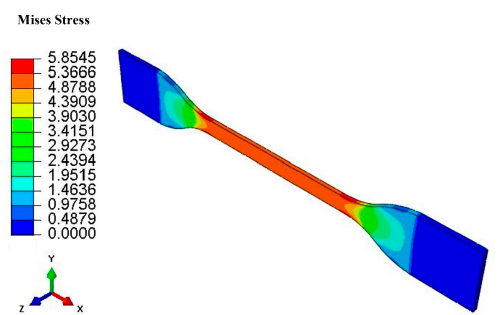
Figure 11. Contour plot of the Mises stress obtained at the peak strain of 40% for the dumbbell-shaped specimen.